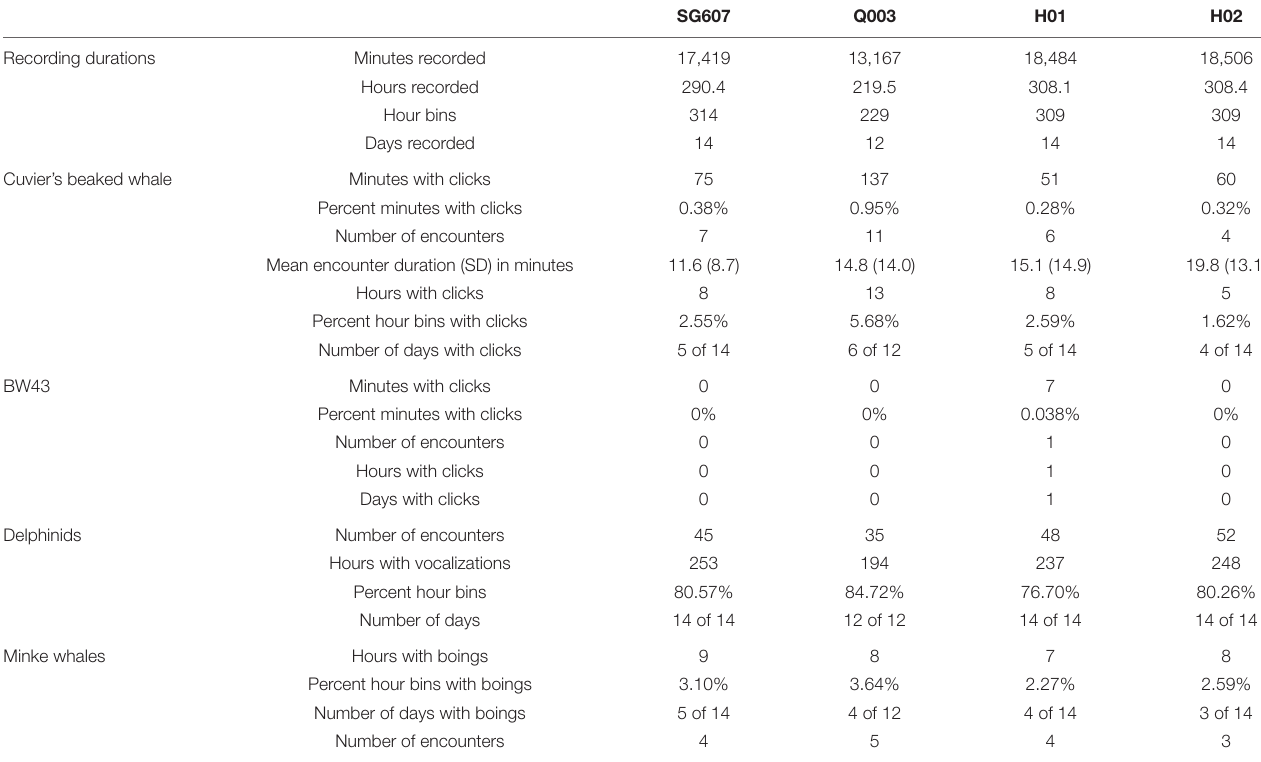
TABLE 2 | Summary of total durations of acoustic data recorded by each platform and minutes, hours, days, and/or encounters for four types of marine mammal vocalization: Cuvier’s beaked whale echolocation clicks, beaked whale echolocation click type BW43 clicks, small delphinid whistles and clicks, and minke whale boings.